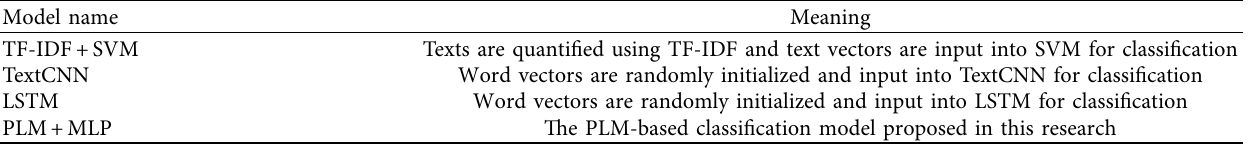
Table 4: Comparative experimental models.